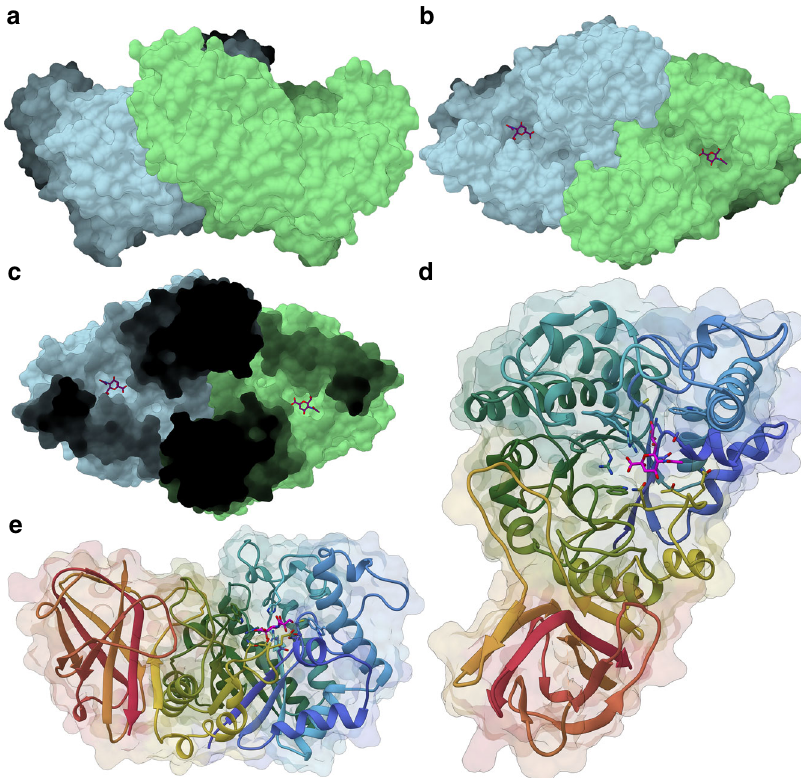
Fig. 2 The 3-D structure of EnvSia156. a , b Van der Waals ’ surface of a EnvSia156 homodimer with one unit colored in light blue and the other in light green. c “ Top-down ” view of the dimer with depth shading highlighting the continuous groove connecting the two binding sites. d , e Ribbon representation of the structure of EnvSia156 with rainbow coloring (N-terminus in blue, C-terminus in red) showing the ( β / α ) 8 -barrel fold of the catalytic module and the eight stranded β -sandwich C-terminal module. A purple colored Neu5Ac molecule in stick representation can be seen bound in the active center of each unit present in panels b –